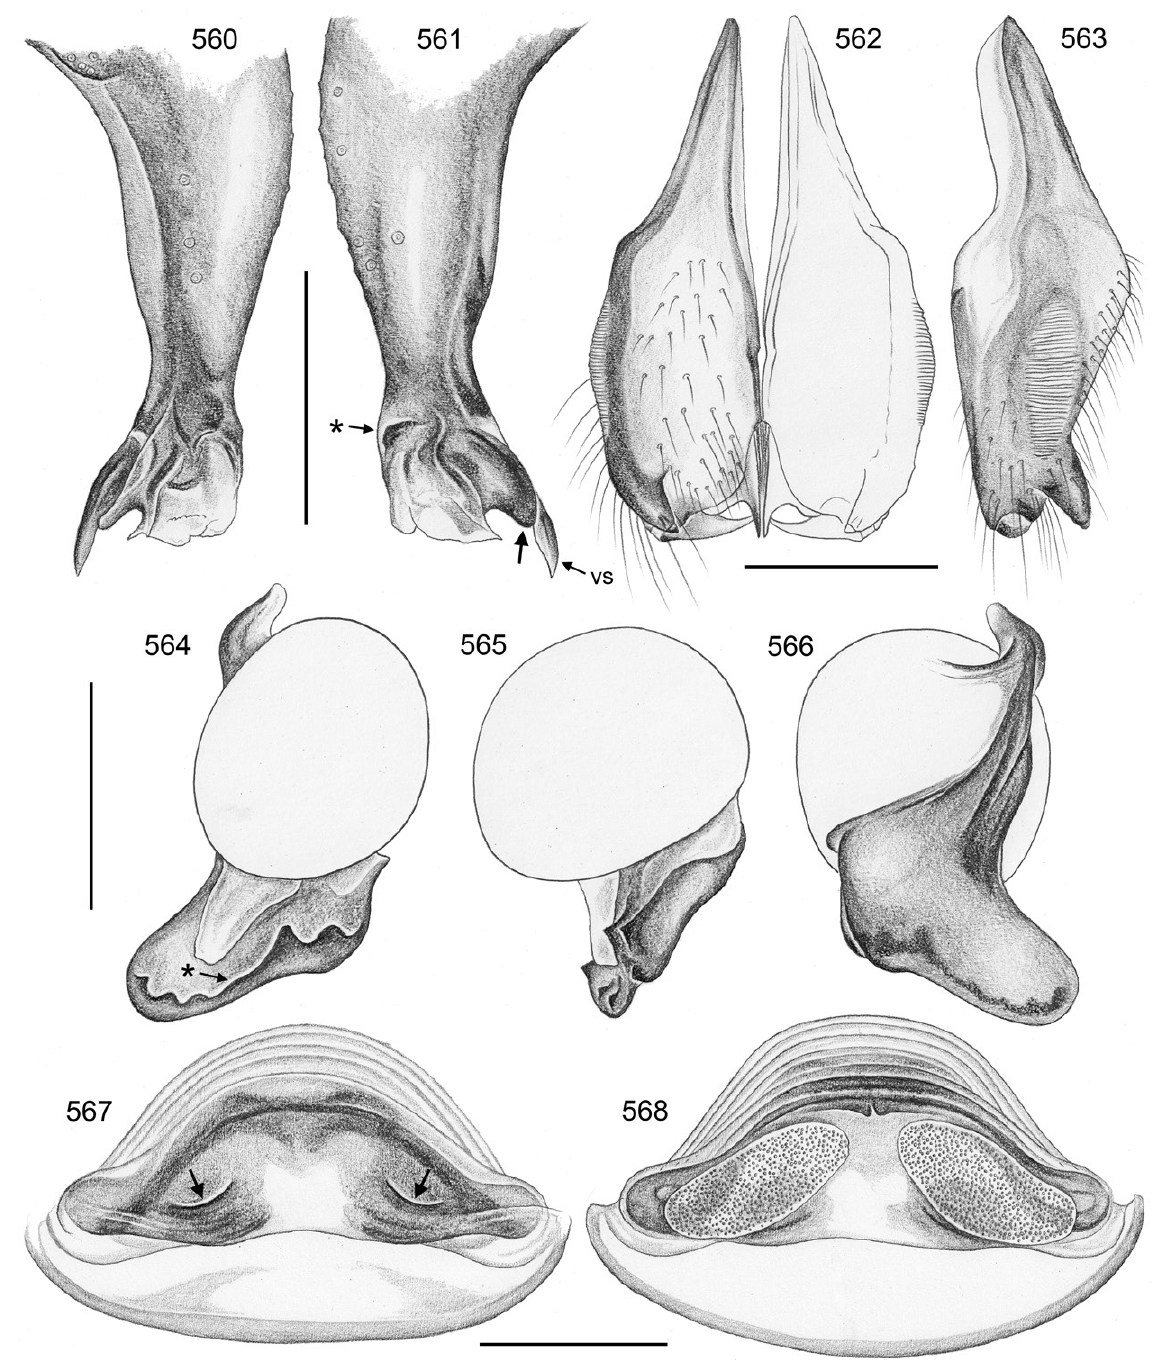
Figs 560–568. Crossopriza khayyami sp. nov., non-type male and female from Iran, Fars, Izad Khast (MHNG). 560–561 . Left procursus, prolateral and retrolateral views; asterisk: process that is larger in specimens from Afghanistan; arrow: distinctive sclerite parallel to ventral sclerite. 562–563 . Male chelicerae, frontal and lateral views. 564–566 . Left genital bulb, prolateral, dorsal, and retrolateral views; asterisk: ridge where specimens from Afghanistan have two additional small apophyses. 567– 568 . Cleared female genitalia, ventral and dorsal views; arrows: pockets. Abbreviation: vs = ventral sclerite. Scale bars = 0.3